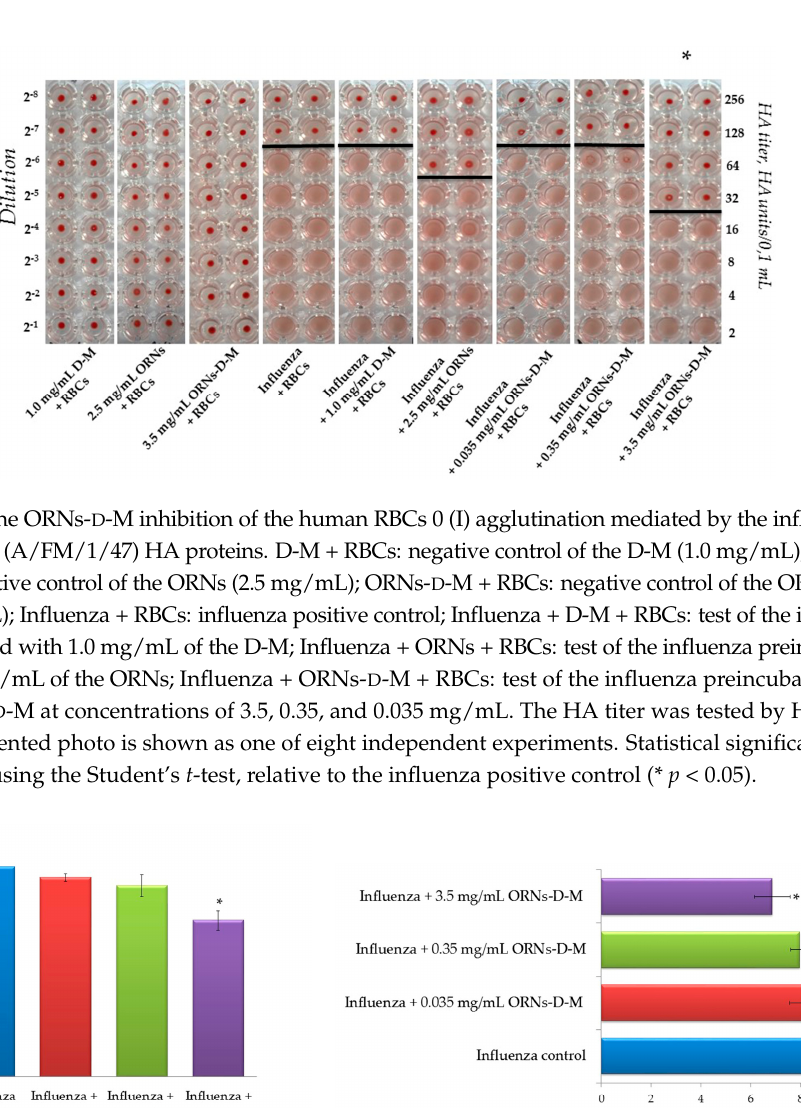
Figure 1. The ORNs- D -M inhibition of the human RBCs 0 ( І ) agglutination mediated by the influenza A virus H1N1 (A/FM/1/47) HA proteins. D-M + RBCs: negative control of the D-M (1.0 mg/mL); ORNs + RBCs: negative control of the ORNs (2.5 mg/mL); ORNs- D -M + RBCs: negative control of the ORNs-